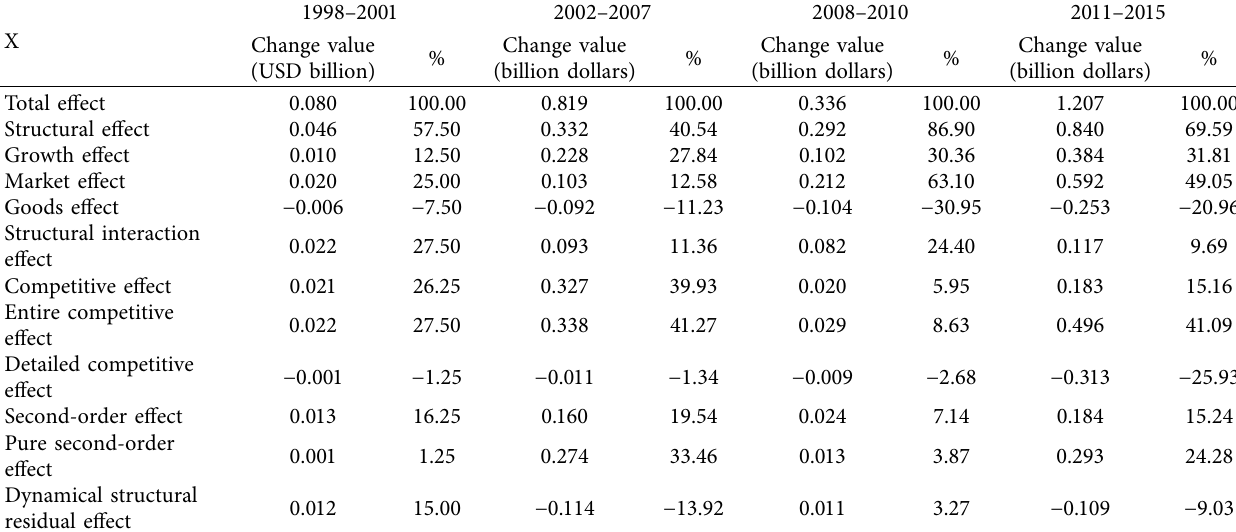
Table 2: Results of the constant market share (CMS) model for Hainan’s exported